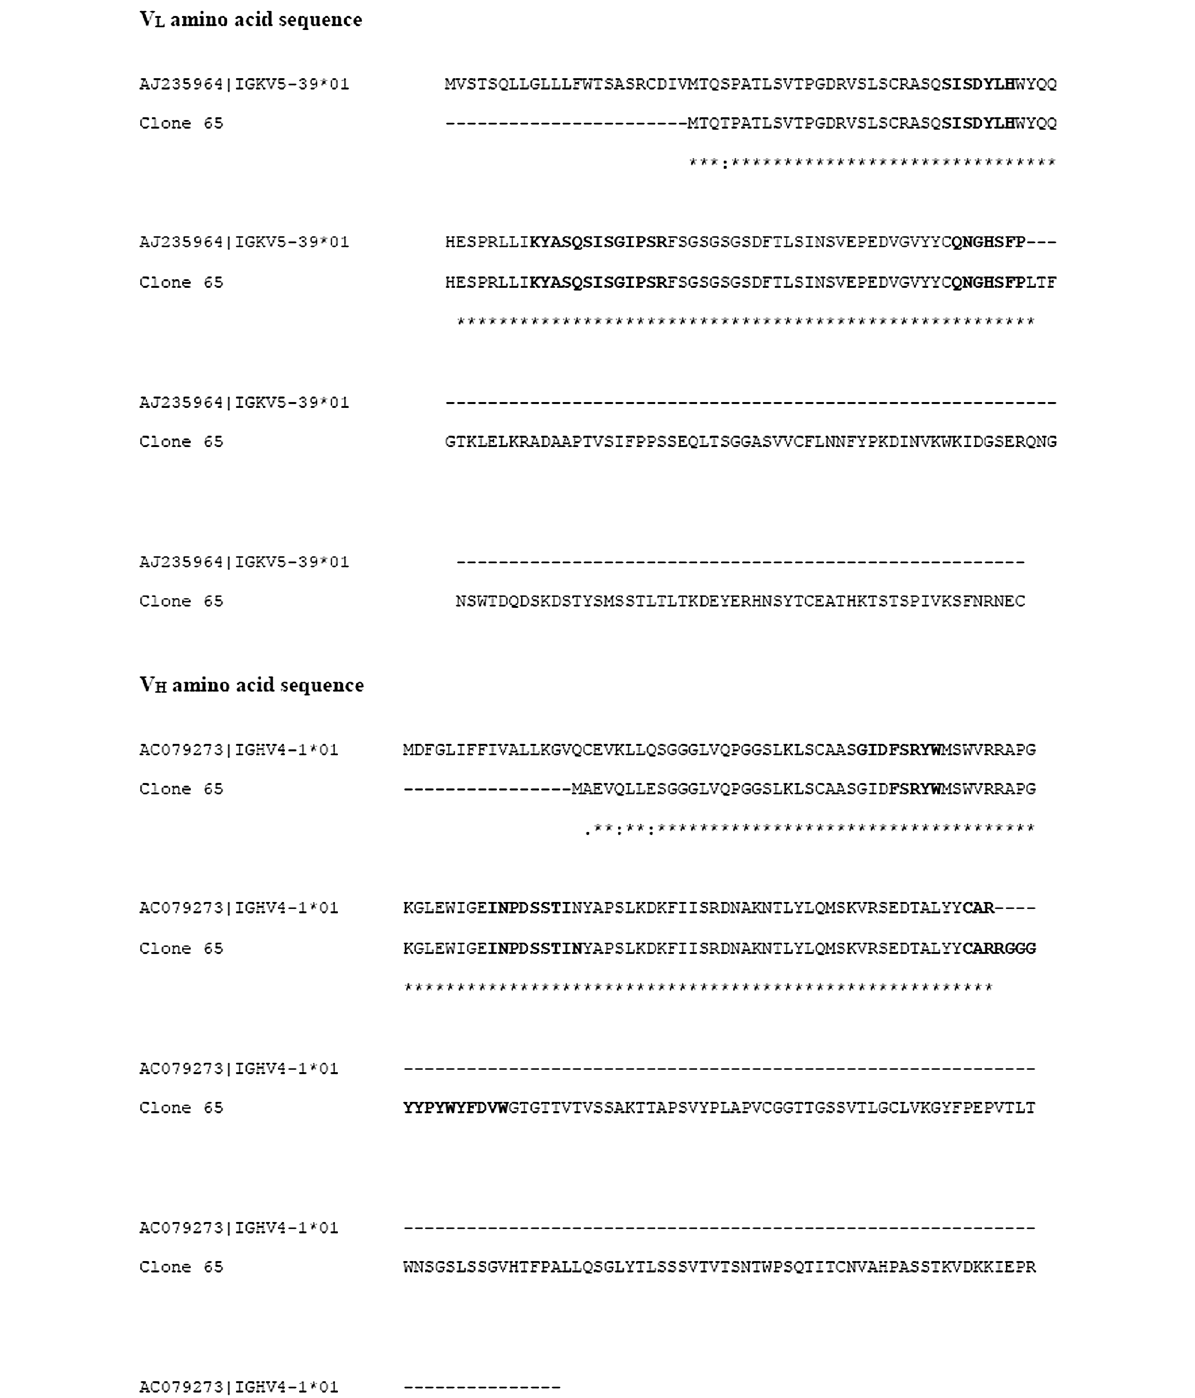
Fig. 2 Amino acid sequences of the variable heavy and the light chains from Fab clone 65 compared to the closest germline (IGHV4-01*01 and IGKV5-39*01) sequences as calculated by the IgBLAST software. CDR’s are indicated in bold. *indicates identity to the uppermost sequence, - no amino acid at this position, : indicates the existence of different amino acids at this